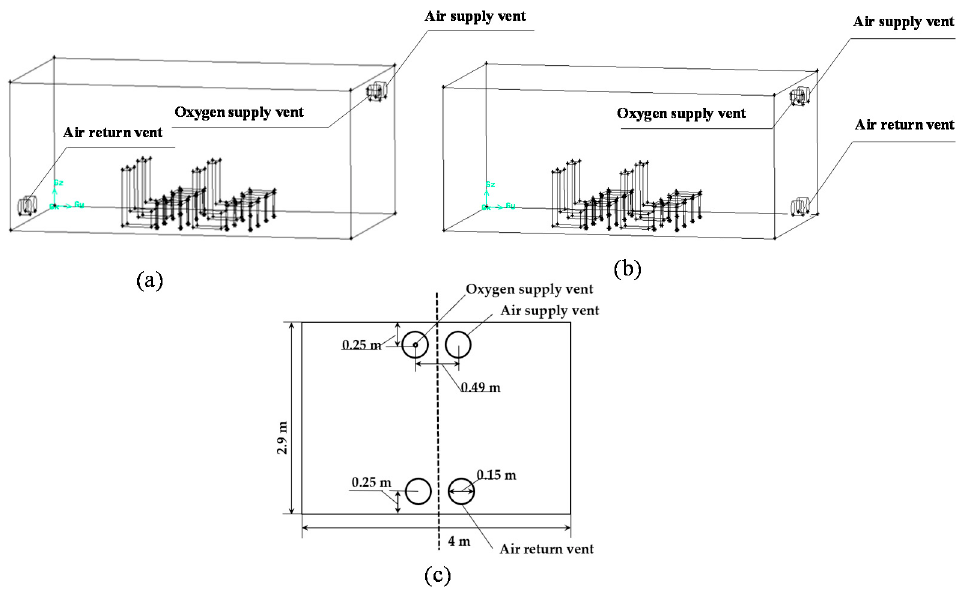
Figure 2. Physical model of the artificial climate chamber (air-conditioned, with single oxygen supply vent). ( a ) Up-supply and down-return on the opposite side, ( b ) up-supply and down-return on the same side, ( c ) side view of the model. Table 1. Structural parameters of the artificial climate chamber. Parameter (m) Distance between the center of the air supply and return vent to the ground Center distance between two air supply and return vents Table surface and legs (length × width × height) Chair surface and back (length × width × height )